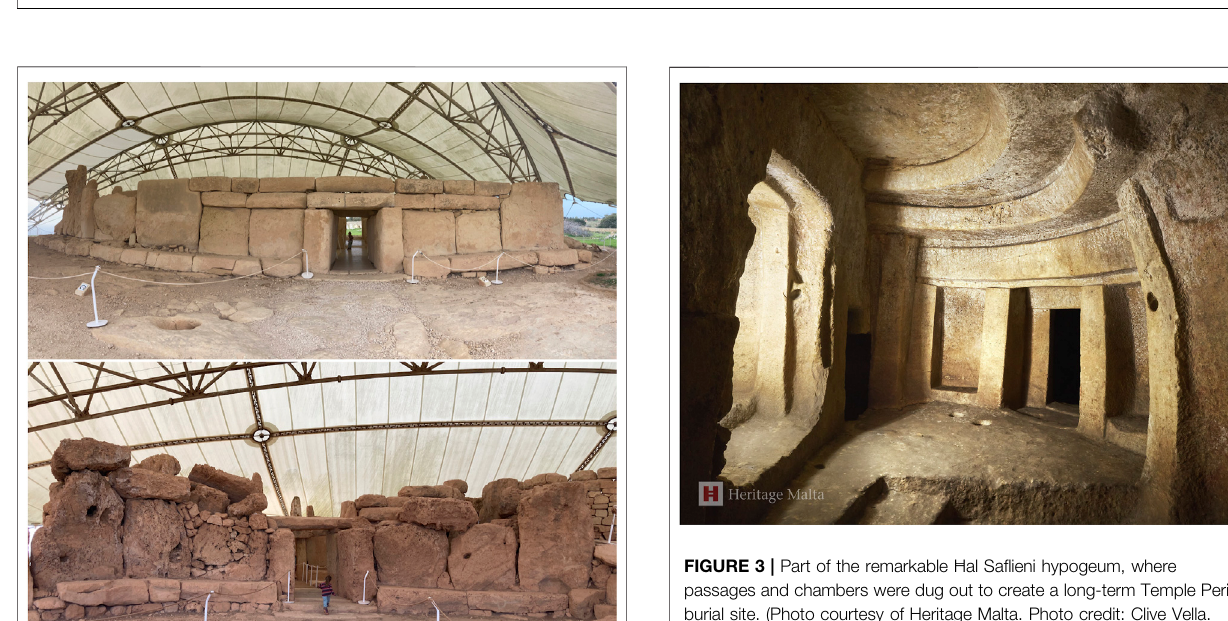
arrival of new groups of humans, and societal unrest (e.g.,